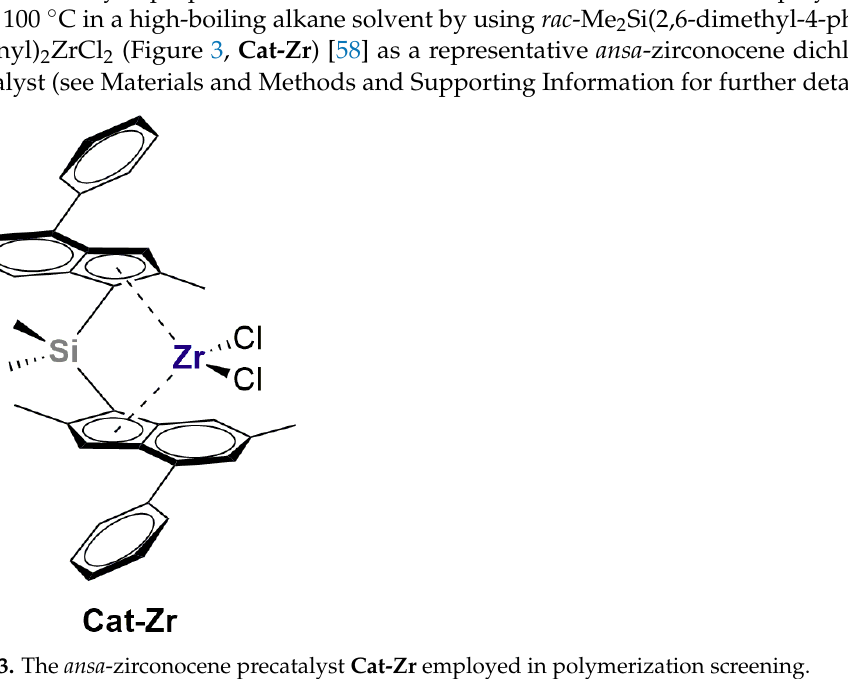
Figure 3. The ansa -zirconocene precatalyst Cat-Zr employed in polymerization screening.